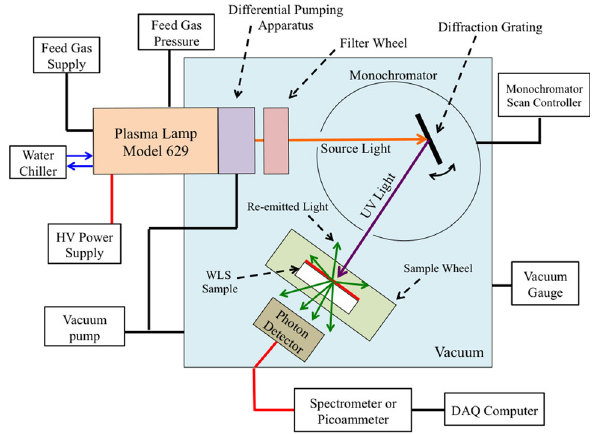
Fig. 6 A cartoon schematic of the experimental setup for the IWC and SWC (Sects. 3.2 and 3.3)